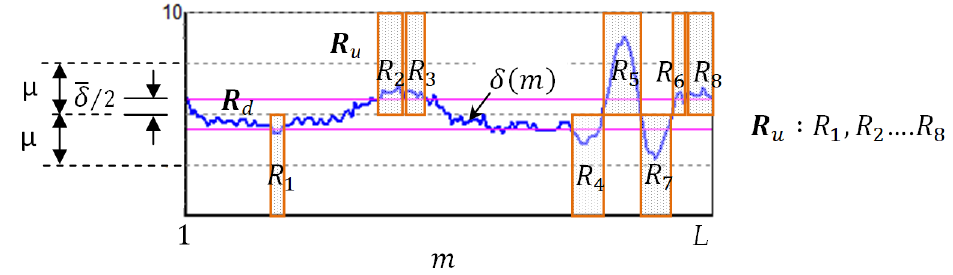
Figure 6. Short window energy curve and regions R (= { R u , R d } )